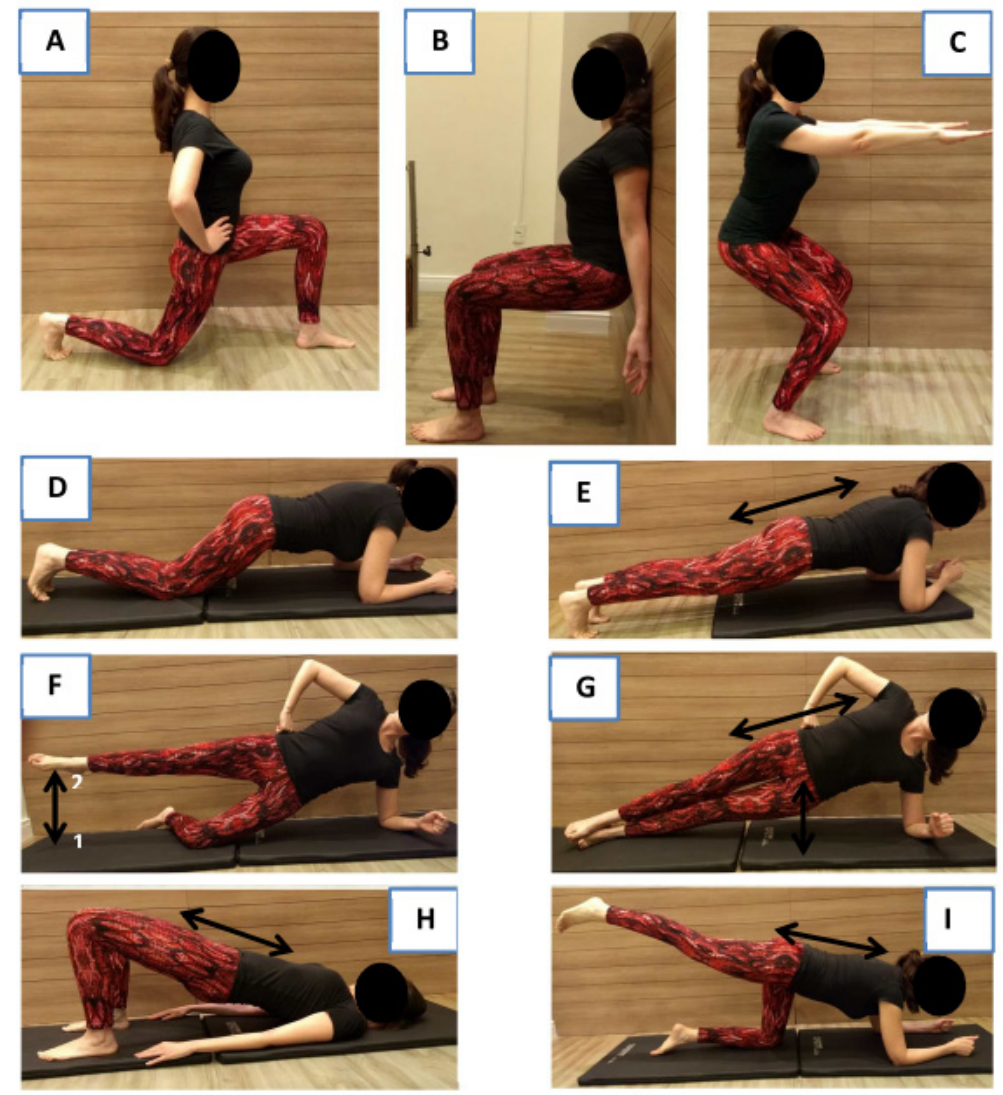
Figure 12. Circuit training for PEx practice during the COVID-19 period. It concerns simple free exercises with no impact on the musculoskeletal system in terms of the su ff ered stress. The muscles’ contributions are described for each picture. ( A ) Postural control and balance training; "stretch" flexors of the hip: rectus femoris and psoas muscles; ( B ) postural control, spinal erectors (m. Spinals) in statics, m. quadriceps strengthening; ( C ) postural control, strengthening of the m. quadriceps and shoulder flexors: long head of biceps brachii, deltoid, coracobrachial muscles; ( D ), ( E ) plank for overall anterior chain reinforcement of the abdominals; ( D ) starting exercise with knees on the floor; ( E ) progression; attention must be paid to keep the back and hip straight; perform the exercises on the right and left sides; ( F ), ( G ) lateral plank, for overall lateral chain reinforcement of the abdominals; ( F ) starting position 1 and, after feeling confident, move to position 2; ( G ) progression, attention must be paid to keep the trunk and hip straight; perform the exercises on the right and left sides; ( H ) bridge exercise, a closed chain weight-bearing exercise which increases muscular strength of the hip extensors and promotes trunk stability; ( I ) postural control, stabilization of m. serratus anterior, shoulder girdle, stabilization of the left pelvic girdle, and reinforcement of the hip extensor on the right: gluteus maximus and hamstring muscles; alternate right and left